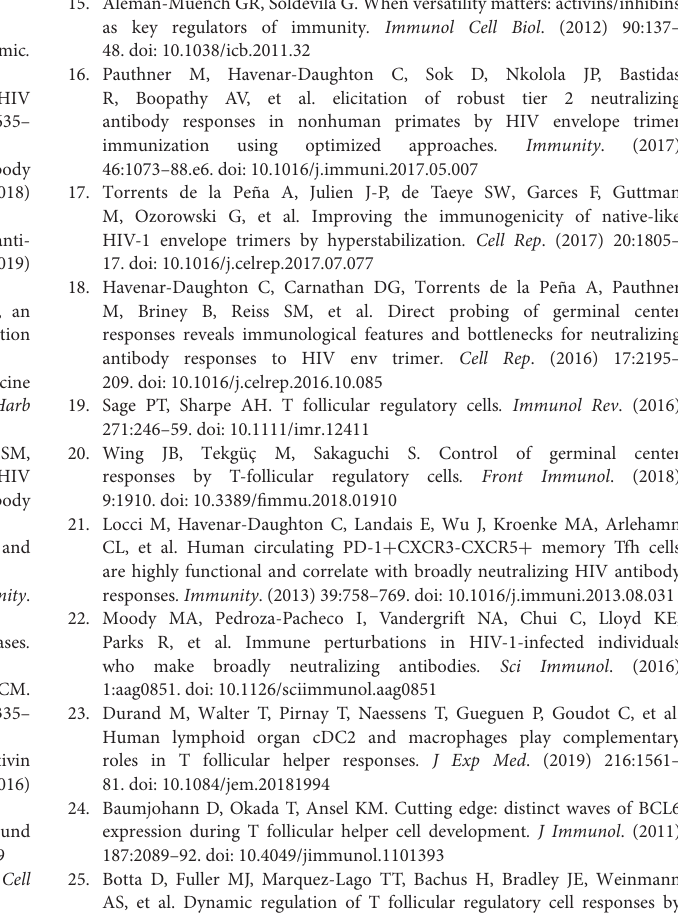
Supplementary Figure 1 | HIV-specific Ab regulation by activin A. (A,B) Env trimer (A) and Env-V3 (B) -specific IgG titers before immunization (preimmune) and at week 10 and week 14 post immunization are shown. Bars show geometric mean with geometric SD. ∗∗ p < 0.01. Supplementary Table 1 | List of animals’ sex; weight, age, previous treatment status at beginning of the study; and immunization and treatment received during the